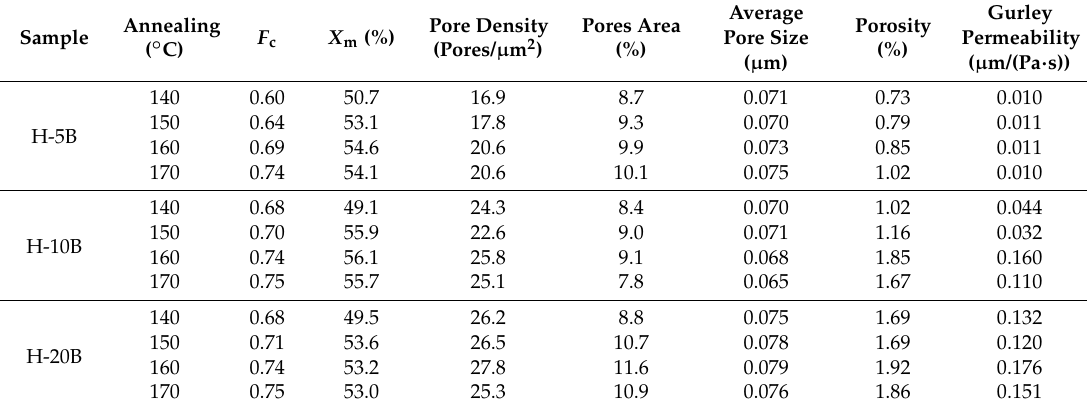
Table 4. Characteristics of membranes prepared with the PP heterophasic copolymer under the same stretching temperature (140 ◦ C), differing on blending ratio and annealing